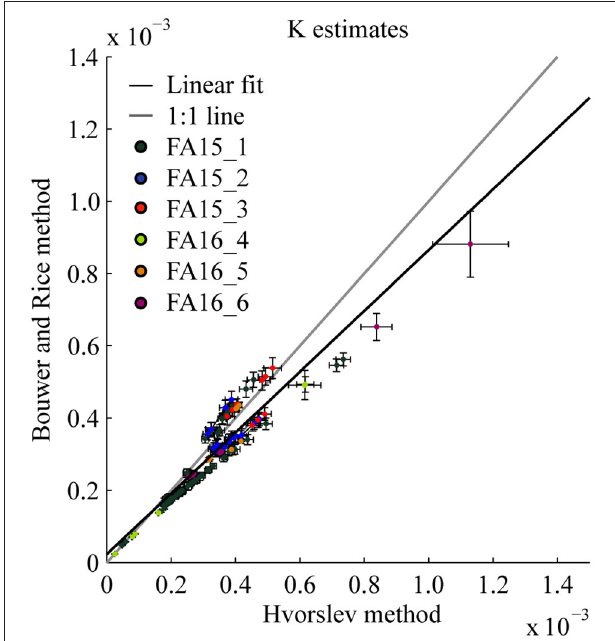
FIGURE 6 | Comparison of hydraulic conductivity estimated using Hvorslev’s method and Bouwer and Rice’s method for each site. Error bars represent standard error of the hydraulic conductivity estimates. A linear fit of these estimates (black line) has a slope of 0.84, intercept of 2 × 10 − 5 , and an r 2 of 0.89 ( r = 0.94). The gray line indicates a 1:1